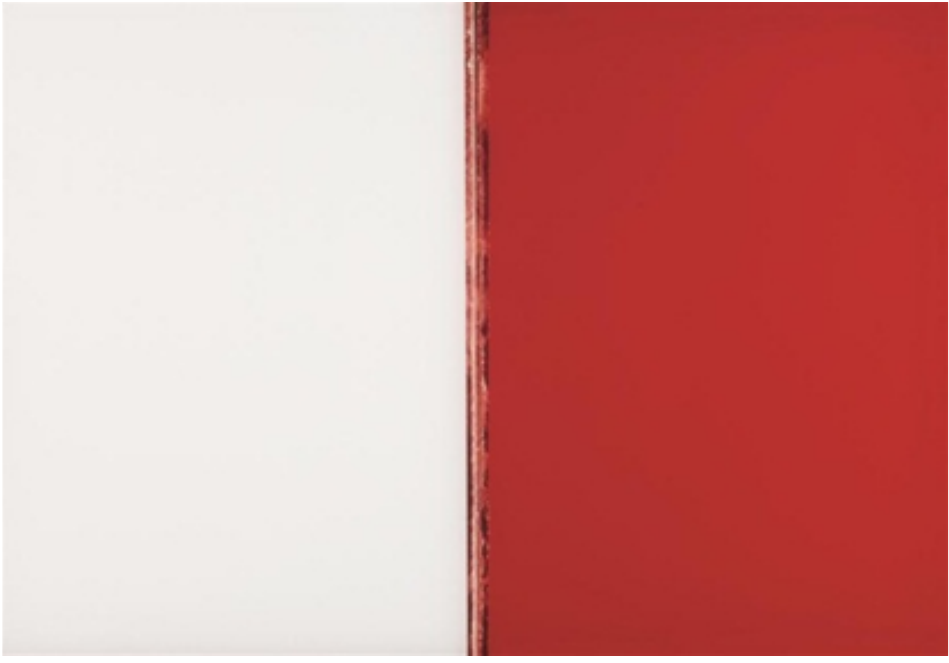
Figure 2 Andres Serano, Milk, Blood, 1987. Cibachrome print, 40 x 60in. (101.6 x 152.4 cm.) Courtesy of Edward Tyler Nahem Fine Art, New York